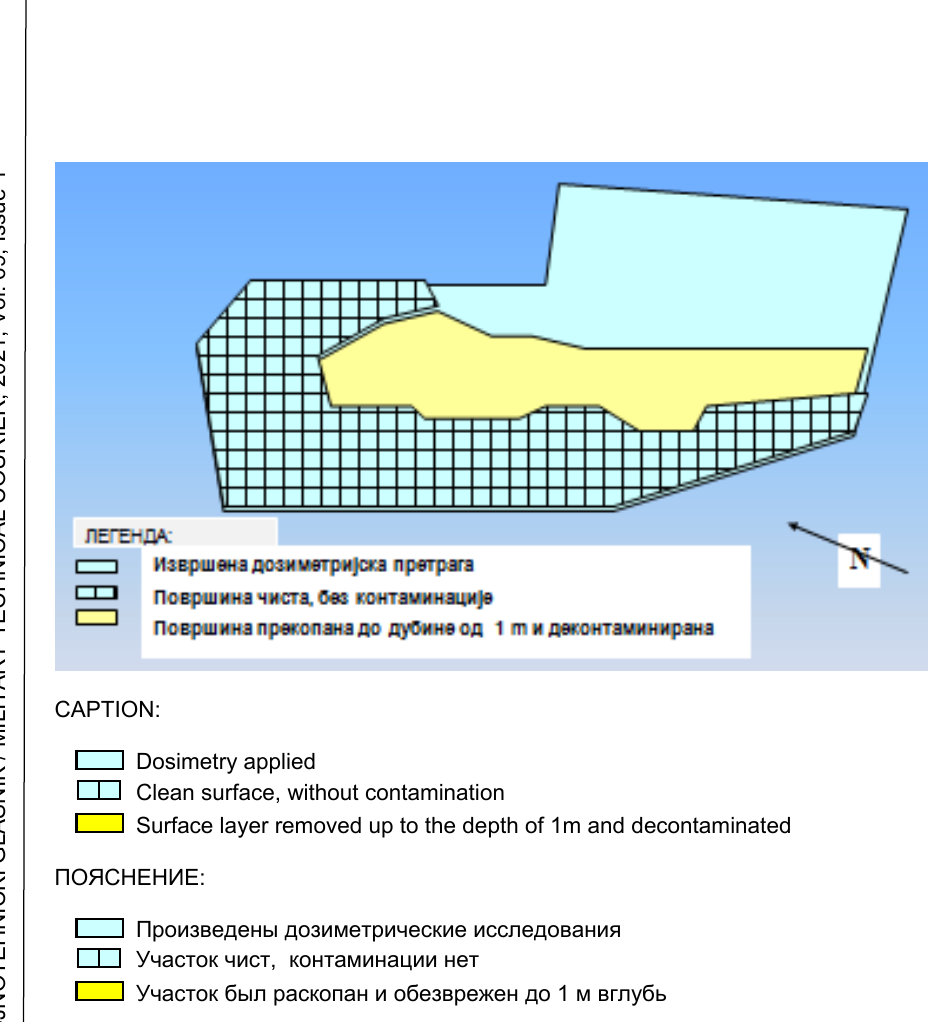
Figure 11 – Scheme of the contaminated land in the village of Bratoselce Рисунок 11 – Схема загрязненной почвы в деревне Братоселце Слика 11 – Шема контаминираног земљишта у селу